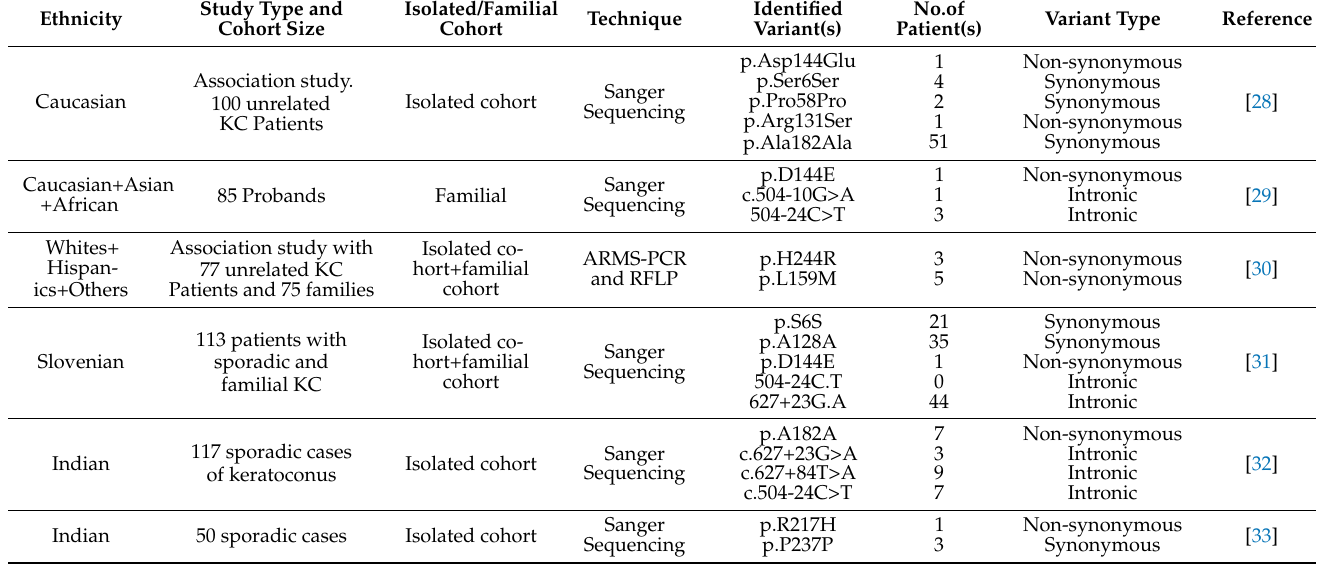
Table 5. Comparison of the studies conducted on same pattern on different ethnicity, study type and cohort size, techniques, identified variants and number of